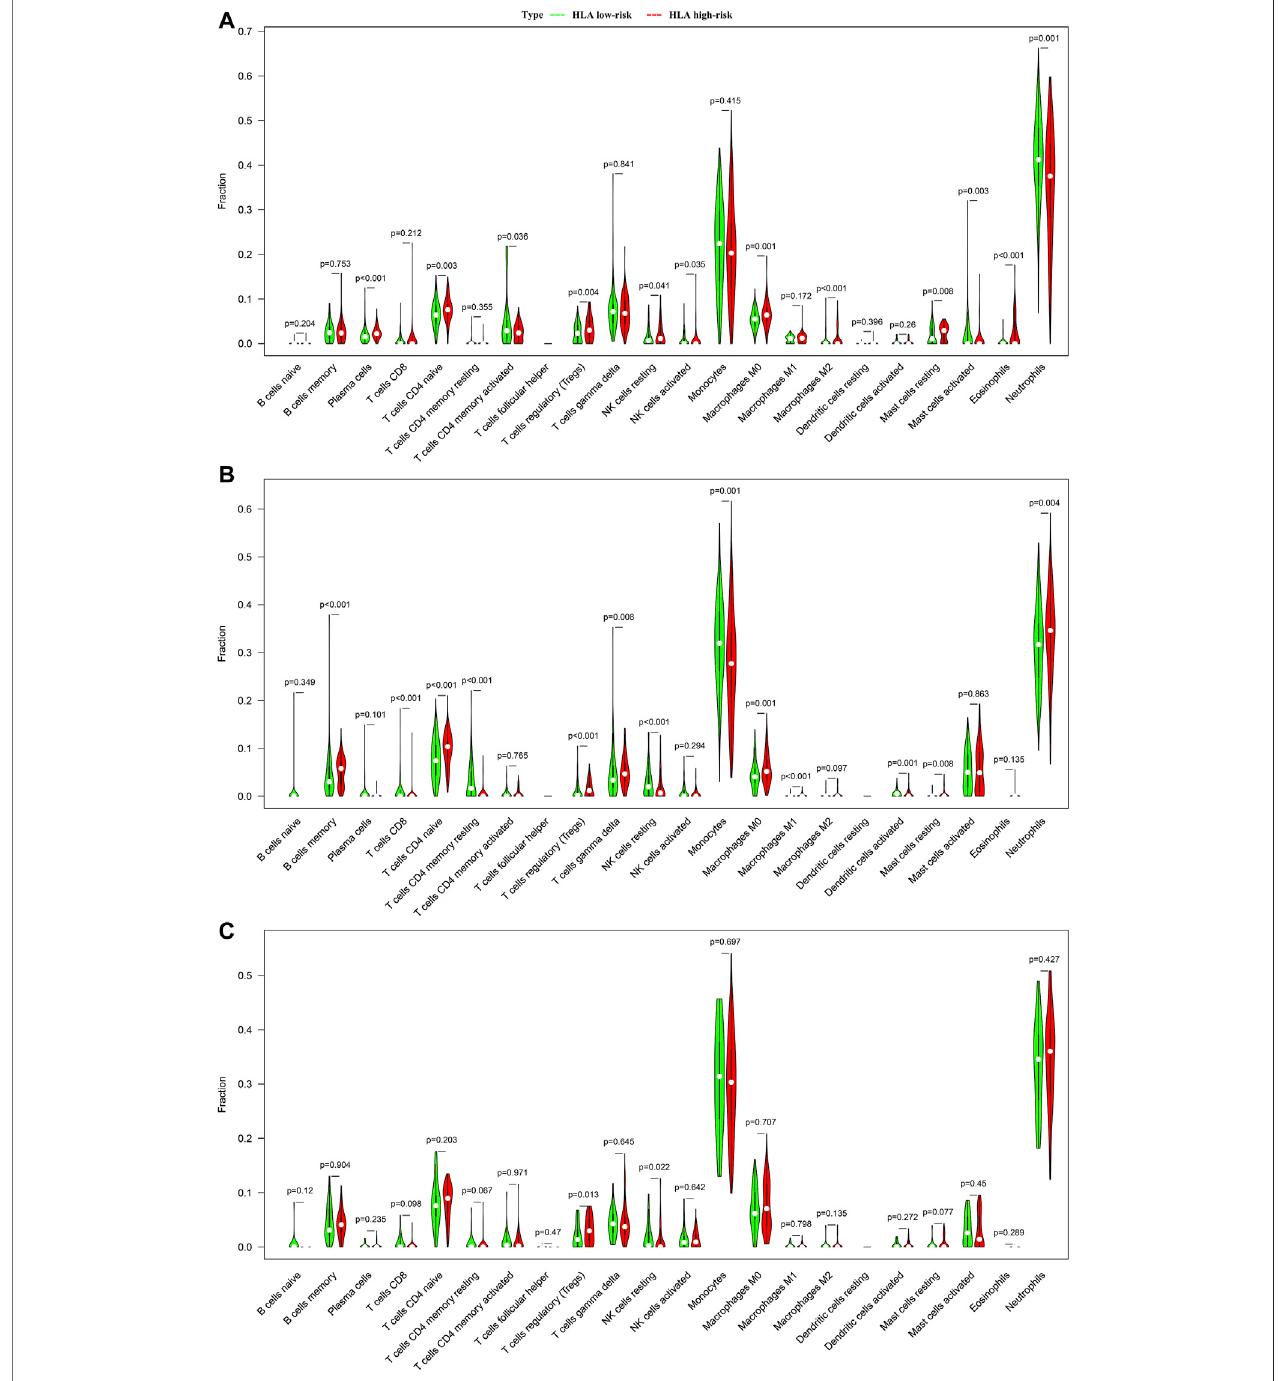
FIGURE 6 | Comparison of in fi ltrating immune cells between different HLA subgroups based on CIBERSORTx in multiple transcriptome datasets. (A) GSE65682 datasets. (B) E-MTAB-4421 datasets. (C) E-MTAB-4451 datasets. Green indicates HLA low-risk, while red indicates HLA high-risk.